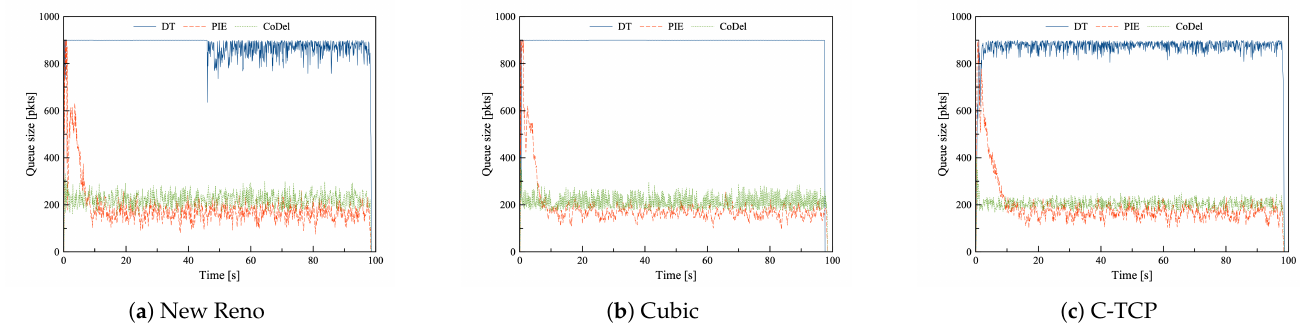
Figure 3. The queue length of DT, PIE and CoDel in combination with ( a ) New Reno, ( b ) Cubic, and ( c ) C-TCP in the Data center scenario with common TCPs during mild congestion.